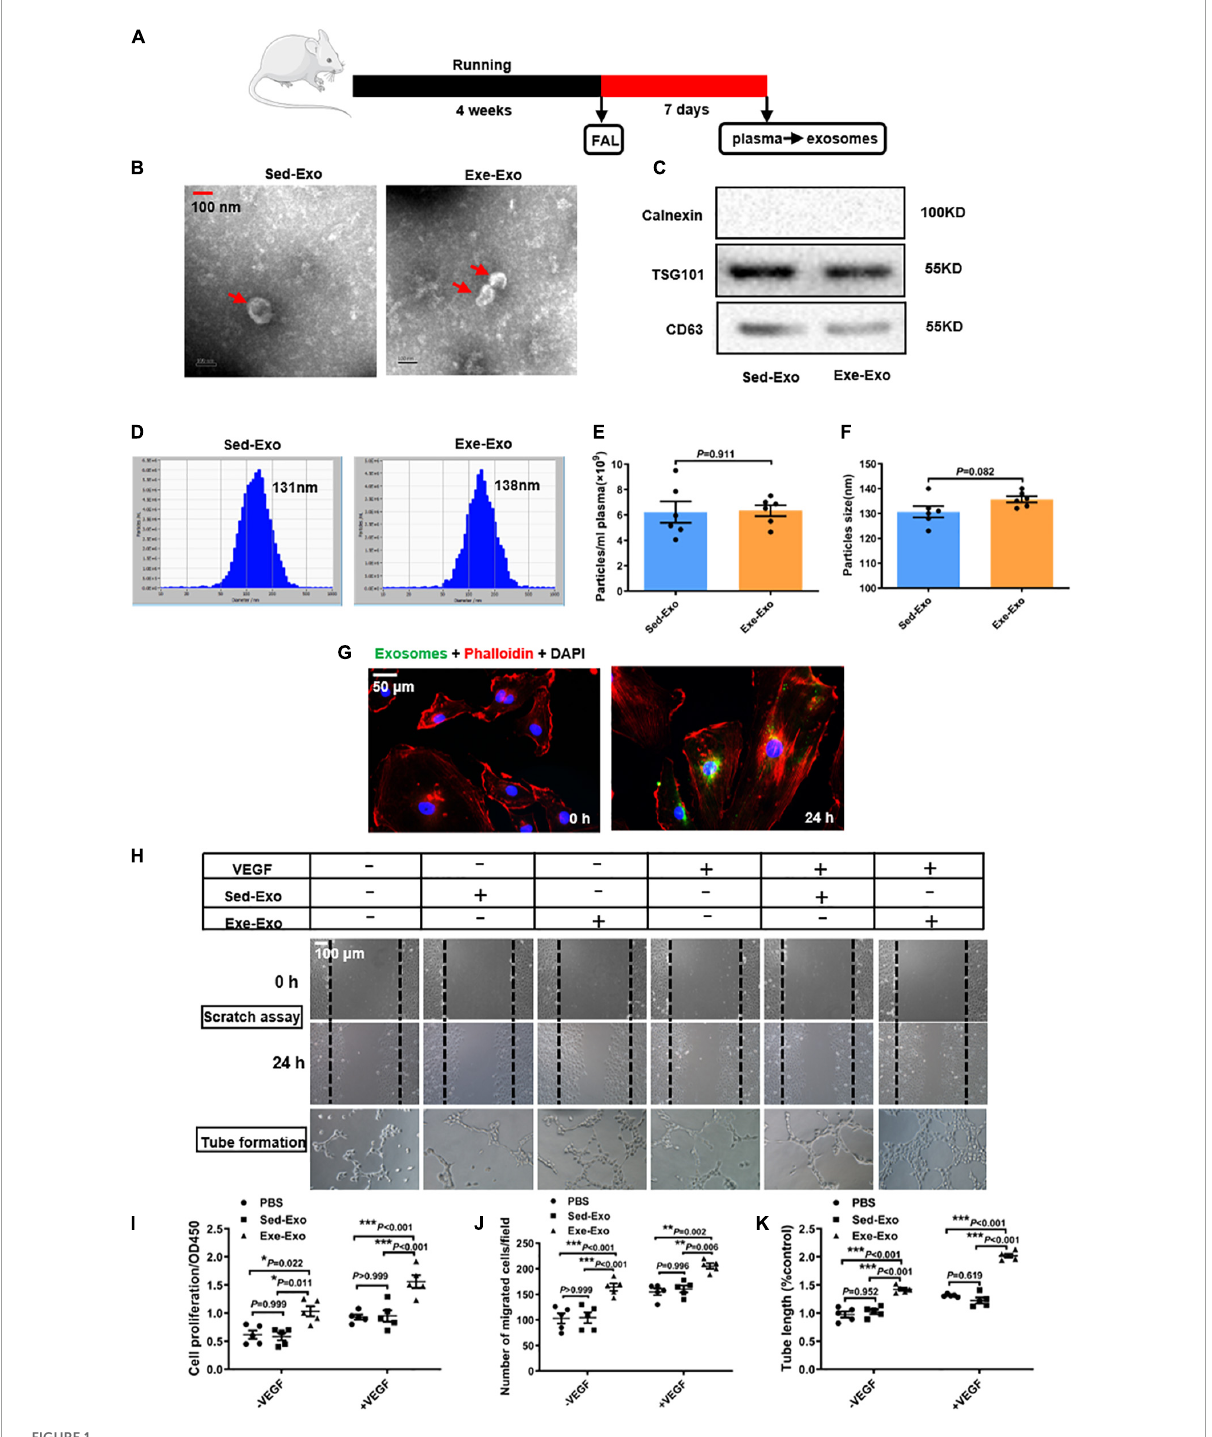
FIGURE1 Characterization and in vitro functional validation of circulating exosomes from sedentary and exercised rats. (A) Schematic diagram of plasma-derived exosome acquisition. Exosomes were isolated from the plasma of rats 7 days after FAL surgery following 4 weeks of running exercise or sedentariness. (B) Representative transmission electron micrographs of Sed-Exo and Exe-Exo. Scale bar = 100 nm. Arrows, representative Exosomes. (C) Representative immunoblots of exosomal marker proteins (TSG101 and CD63) and negative control protein (calnexin) in Sed-Exo and Exe-Exo. (D–F) Representative results of nanoparticle tracking analysis of Sed-Exo and Exe-Exo. Quantitative analysis of the average concentration (E) and size distribution (F). (G) Internalization of PKH67-labeled exosomes. HUVECs were incubated with exosomes for 0 or 24 h. Representative images showing the internalization of PKH67-labeled exosomes (green) by HUVECs. Red, Phalloidin, used for staining actin filaments. Green, PKH67-labeled exosomes (H–K) . Cultured HUVECs were incubated with Sed-Exo (50 µ g/ml) or